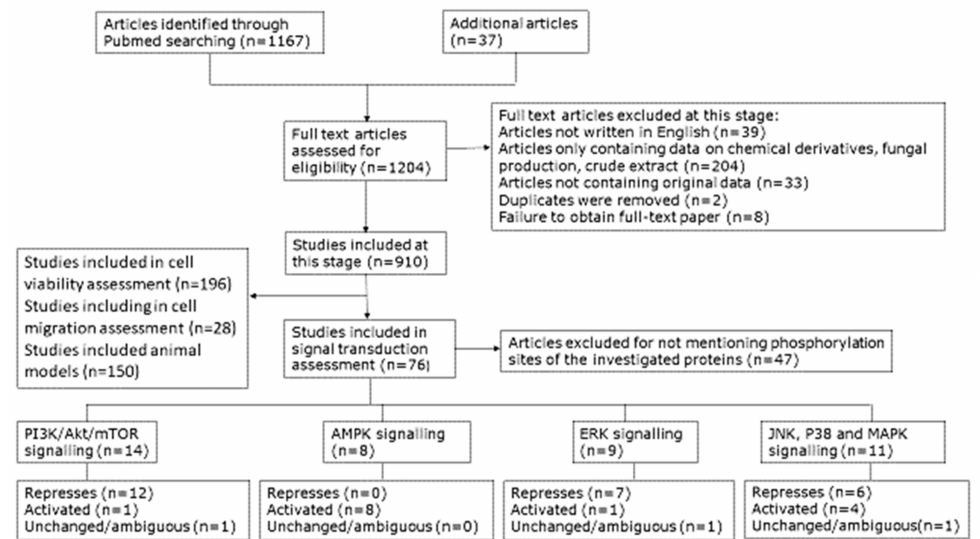
Figure 4. Diagram presenting the selection process for inclusion of publications in this review; n = number of articles.